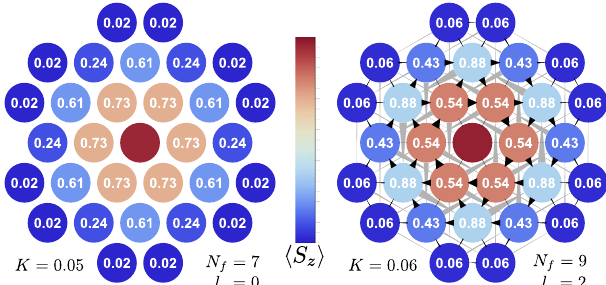
FIG. 2. Magnetic structure of a quantum skyrmion calculated for a flake with 31 sites embedded in a ferromagnetic back- ground. The quantum skyrmions shown are bound states of 7 (left) and 9 (right) flipped spins ( J 2 ¼ 0 . 5 ; left K ¼ 0 . 05 , right K ¼ 0 . 06 ). The color encodes h S z i i . The numbers in the circles show antiferromagnetic correlations of the skyrmion spin in the xy plane, C − 4 h S x S x S y S y S ¯ ⊥ ¼ i is the spin located at ¯ i i , where ¯ i þ i i position − r i opposite to the spin S i located at position r i . Note that h S x i i ¼ h S y i i ¼ 0 as the quantum skyrmion is an eigenstate of S z . The left-hand panel displays a linear superposition of sky- rmion and antiskyrmion ( l z ¼ 0 ) with vanishing spin currents [cf. Fig. 1(e)]. The right-hand panel displays a many-body state with finite angular momentum ( l z ¼ 2 ) which we identify as a quantum skyrmion. The width of the black and gray arrows indicates the size of the z component of the spin current (largest value: 0 . 1 J 1 ) on nearest-neighbor and next-nearest-neighbor links,